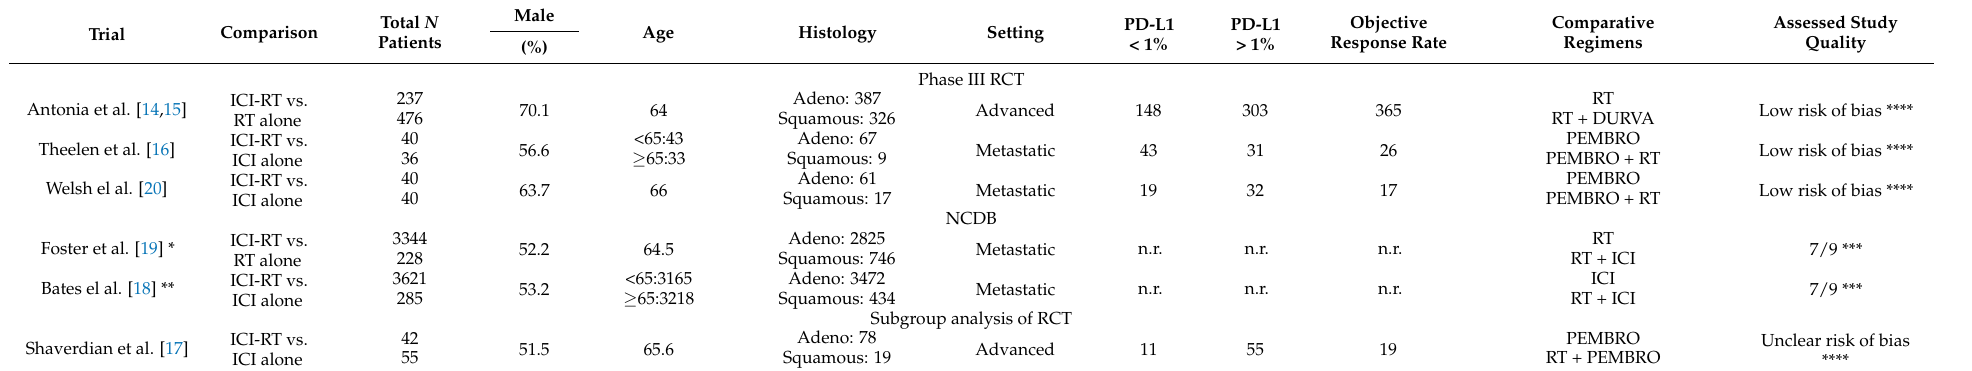
Table 1. Characteristics of NSCLC patients in studies included in the